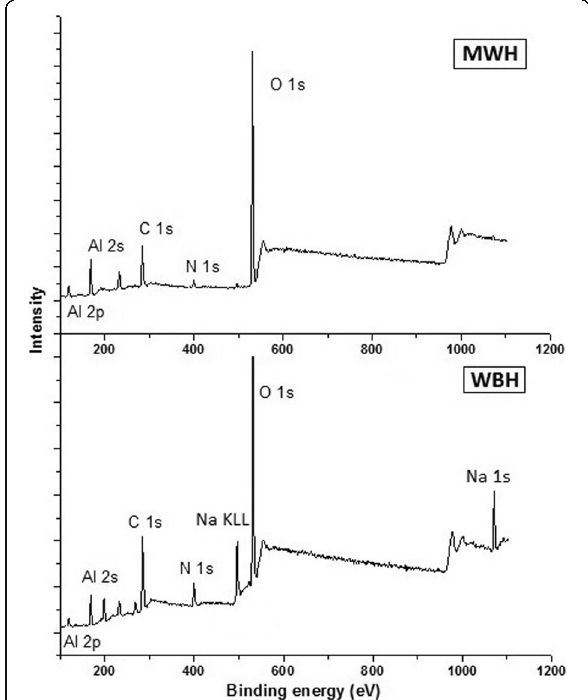
Fig. 9 XPS spectra of aluminum tanned skin pieces under different heating